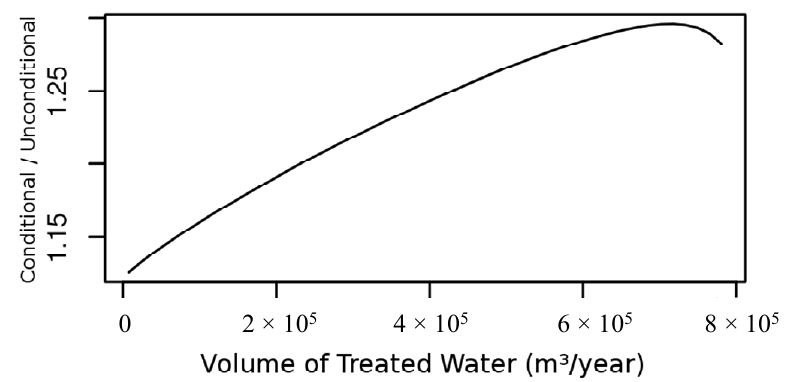
Figure 4. Partial regression plot of VTW (m 3 /year).